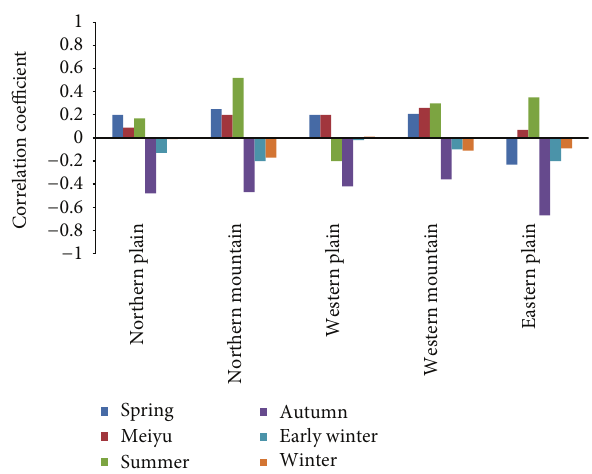
Figure 7: Correlation coefficients between rainfall anomaly and Ni˜no 3.4 at five subareas during canonical La Ni˜na episode.